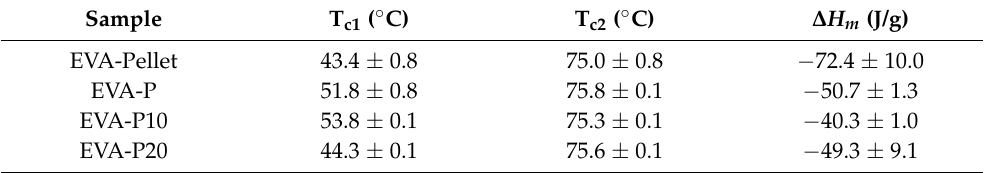
Table 3. Thermal behavior data obtained from DSC cooling cycle for EVA and EVA/ACV